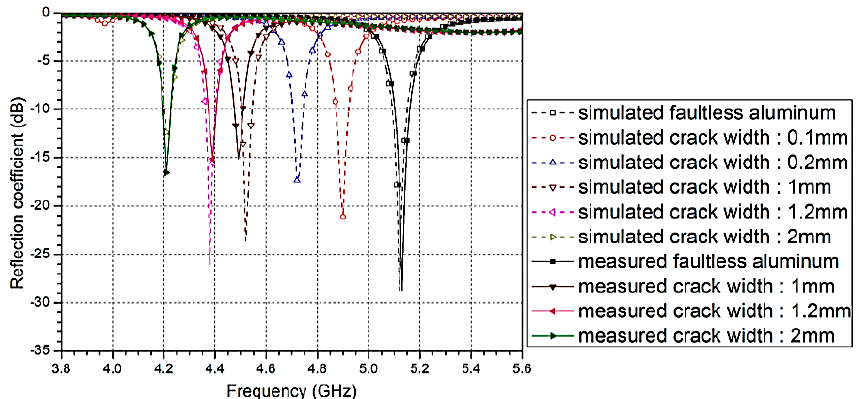
Figure 32. Simulated and measured results of the reflection coefficient for a crack depth of 2 mm (from [41]; copyright © 2014; reproduced with permission). Metals 2016 , 6 , 172